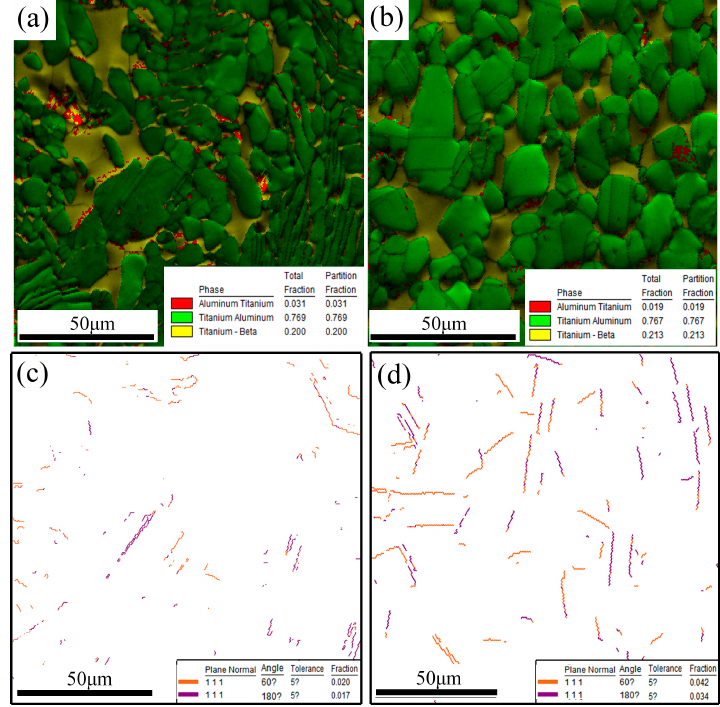
Figure 6. Phase composition of the Ti-43Al-9V-0.2Y alloy and twin boundary distributions of the γ phase: ( a , c ) As-forged; ( b , d ) Hot-rolled.